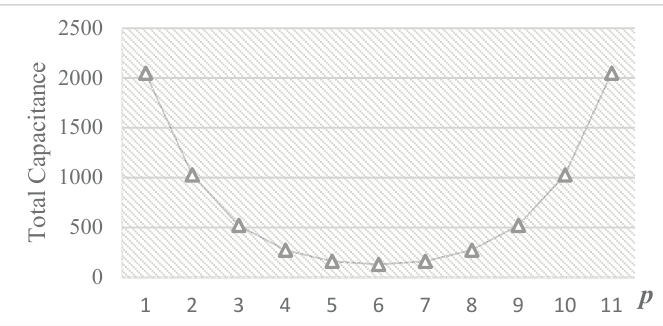
Figure 1. The total number of unit capacitors vs. p